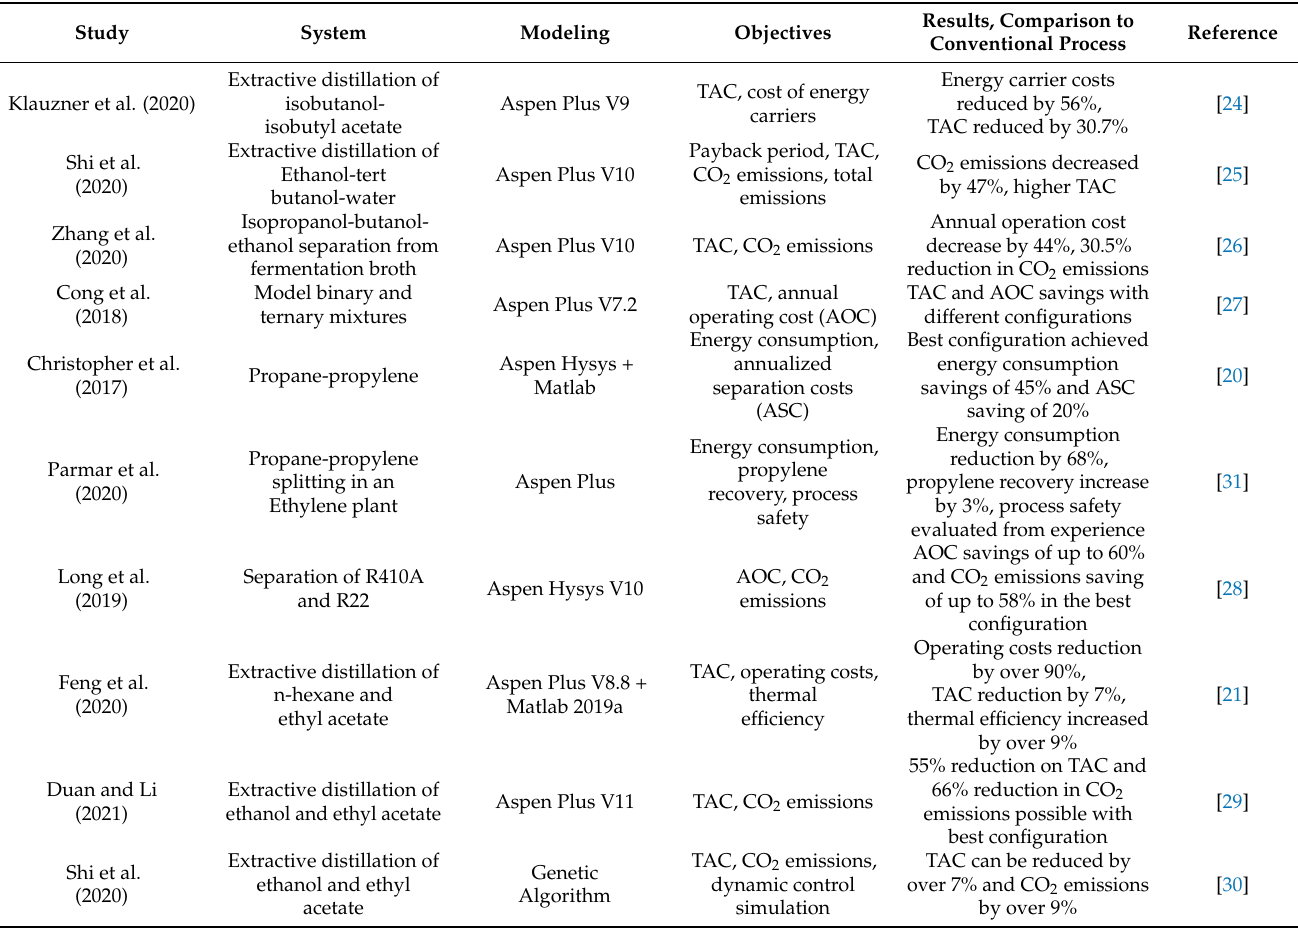
Table 1. Current state of research on heat pumps